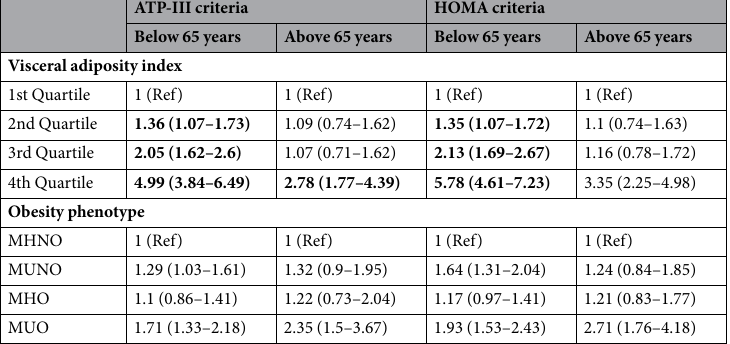
Table 5. Adjusted odds ratios (OR) and 95% confidence intervals (CI) of the presence of hyperuricemia associated with the visceral adiposity index, along with metabolic health and obesity phenotypes stratified by age groups. Abbreviations : ATP-III, the Adult Treatment P anel-III; HOMA, homeostasis model assessment of insulin resistance; MHNO, metabolically healthy non-obese; MUNO, metabolically unhealthy non-obese; MHO, metabolically healthy obese; and MUO, metabolically unhealthy obese. Model was adjusted for age, sex, urban/rural resident, smoking status, alcohol status, metabolic health-obesity phenotypes, white blood cell, total cholesterol, blood pressure, glucose and